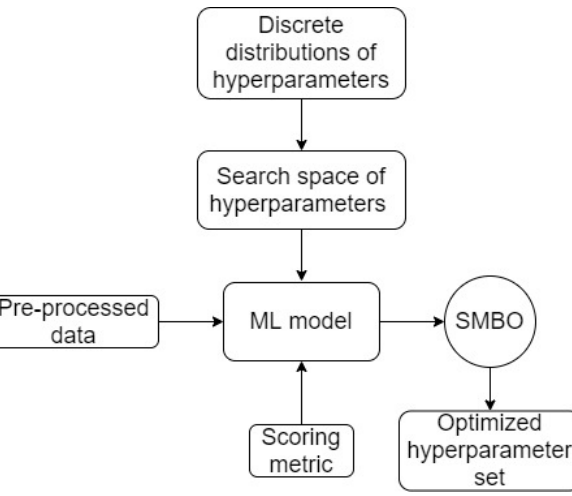
Figure 9. Schematic of workflow 2.